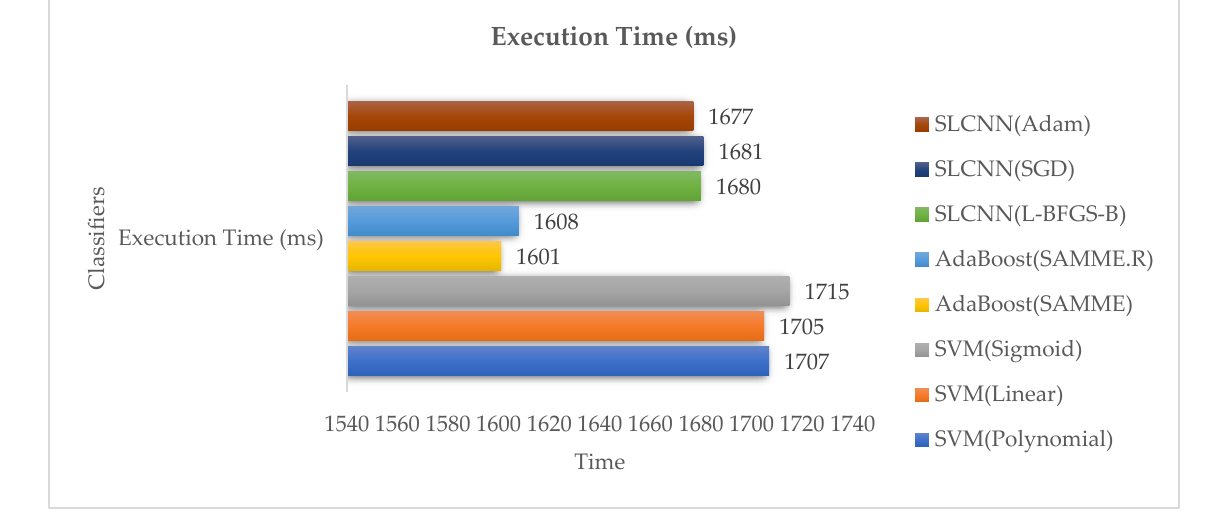
Figure 10 indicates the time taken for the implementation procedure. AdaBoost accomplishes the lowest period of execution and implementation time as compared to SVM and SLCNN.